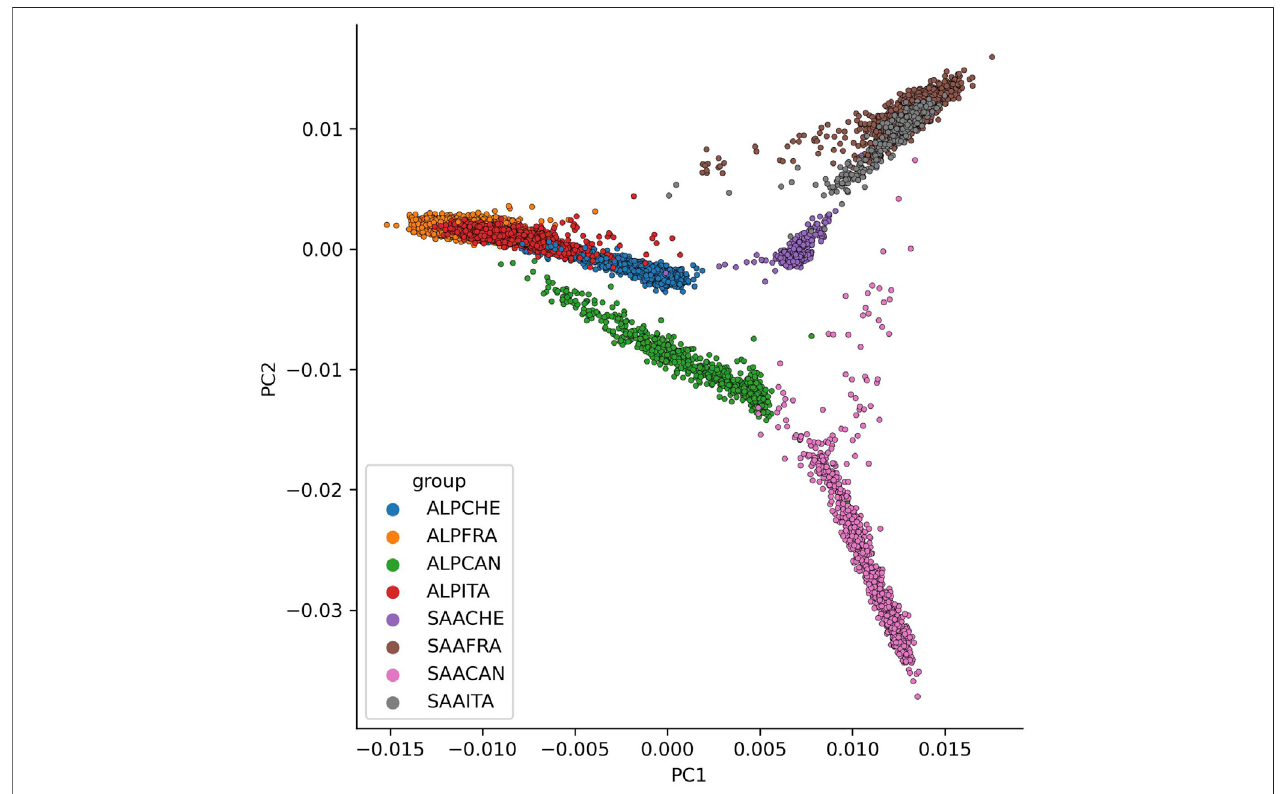
FIGURE 4 | Principal component analysis (PCA) with all genotypes for each breed (ALP, Alpine; SAA, Saanen) and country (CAN, Canada; FRA, France; ITA, Italy; CHE, Switzerland) on the two fi rst PCA components (PC1 to PC2).